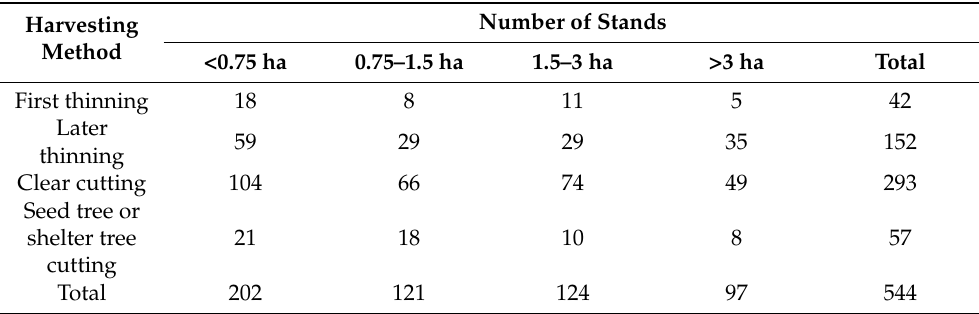
Table 1. The number of automatically delineated stands in this study by harvesting method and stand area